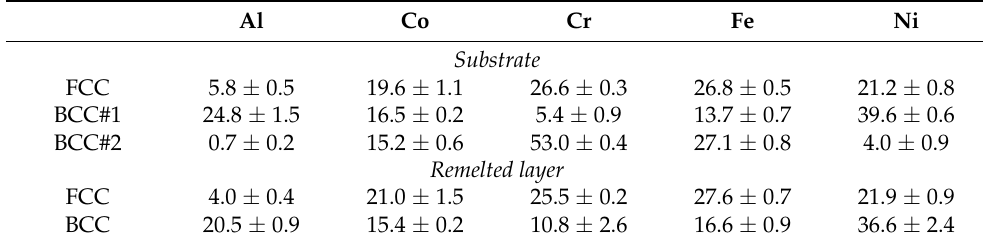
Figure 3. TEM analysis for the substrate. ( a ) BF image and SAED patterns; ( b ) STEM image and EDS elemental maps of the rectangle region marked in ( a ). Table 1. TEM-EDS results (at.%) for the different phases in the substrate and remelted layer.